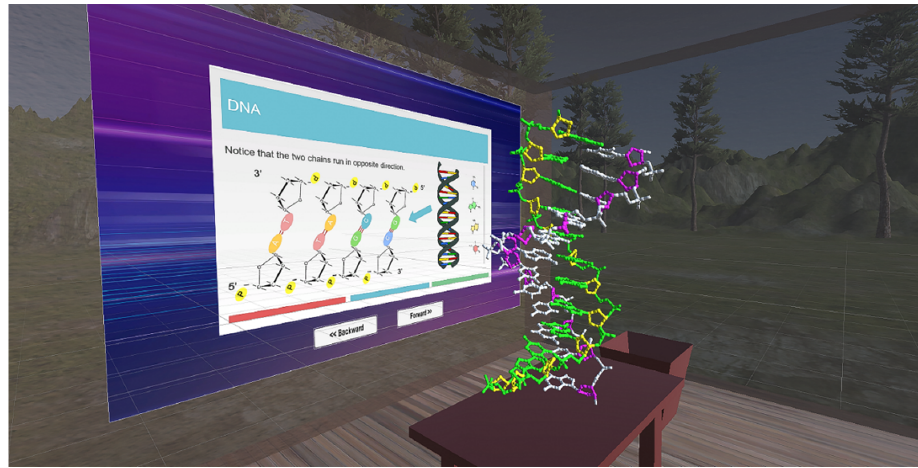
Figure 3. Examples of content for VR: 3D representation of adenine.